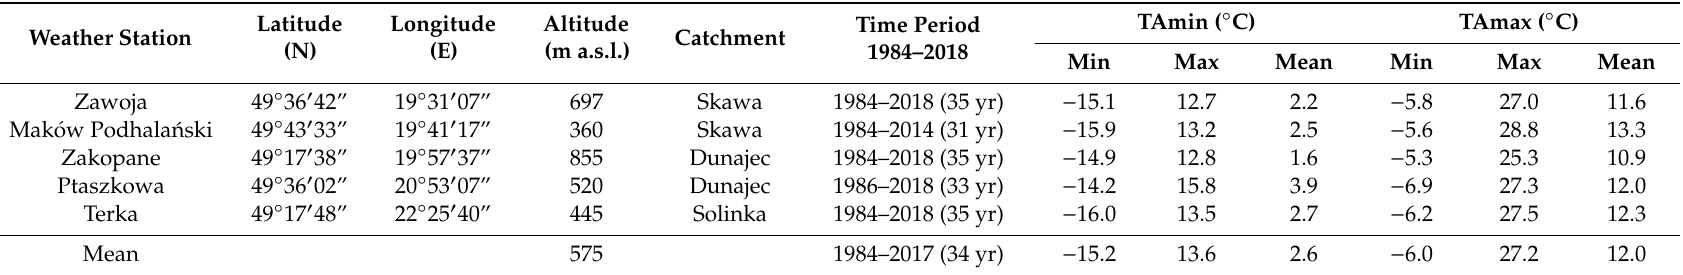
Table 2. Details of weather stations used in the study (arranged from west to east) and monthly air temperature (TAmin, TAmax) characteristics. Weather